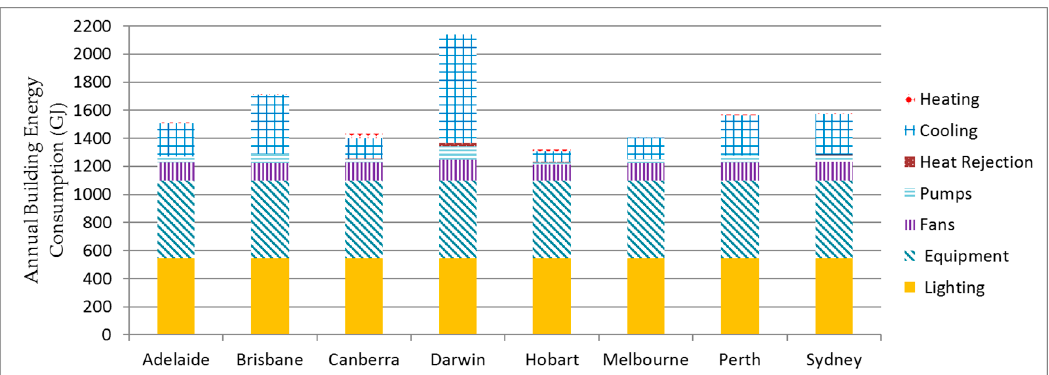
Figure 9. Annual building energy consumption of the conventional VAV system.